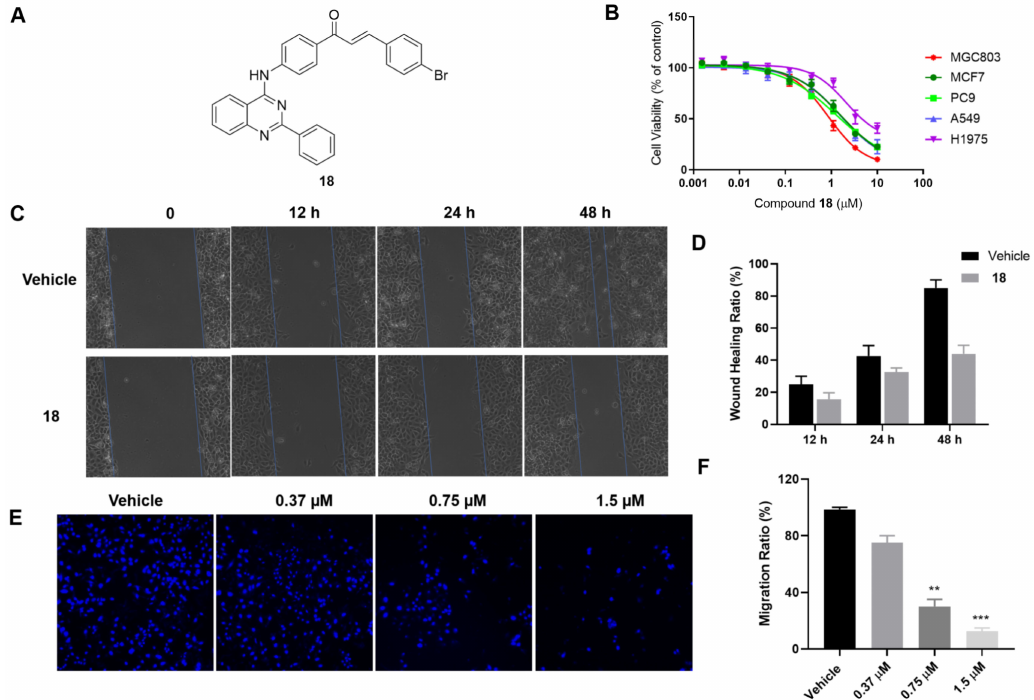
Figure 2. The effect of compound 18 on the migration of MGC-803 cells. ( A ) The structure of com- pound 18 ; ( B ) The effect of 18 on the cell viability of selected cancer cells with different concentrations for 72 h by MTT method; ( C , D ) The effect of 18 at 1 µ M on the migration of MGC-803 cells in a wound healing assay; ( E , F ) The effect of 18 on the migration of MGC-803 cells for 48 h in a transwell assay. ** p < 0.01, *** p < 0.001 compared to control